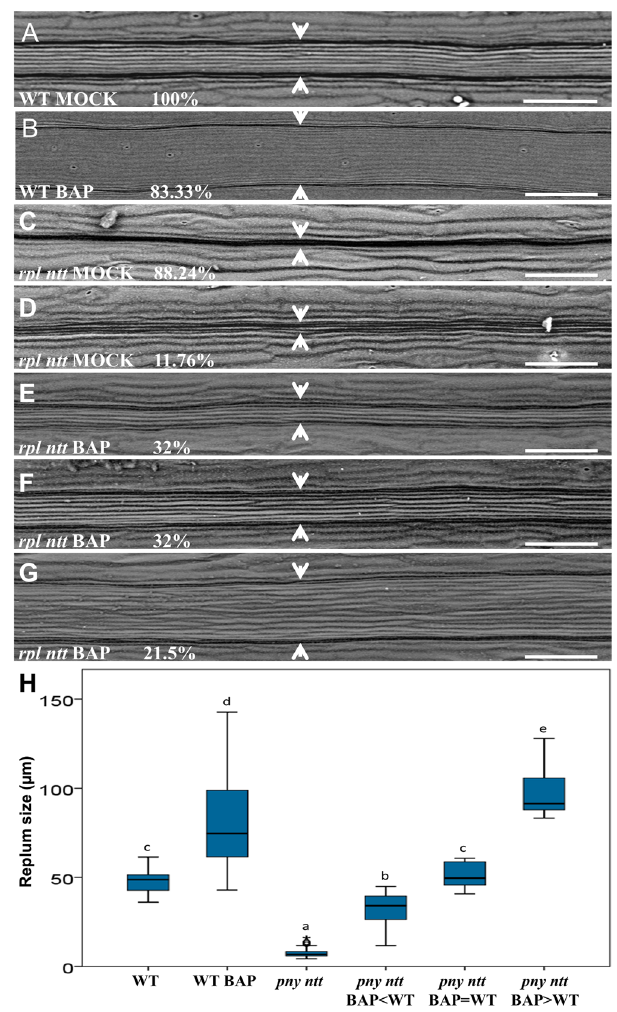
Figure 6. Exogenous cytokinin application increases replum size in Arabidopsis thaliana . ( A ) Mock-treated wild type gynoecium. ( B ) BAP-treated wild type gynoecium that developed a wider replum. ( C , D ) Mock- treated rpl ntt gynoecium that lacks or has a very narrow replum, respectively. ( E – G ) BAP-treated rpl ntt gynoecia where replum development is recovered, at different levels (arbitrary divided in three groups): The replum developed less than observed in WT ( E ); The replum developed as observed in WT ( F ); The replum developed more than observed in WT ( G ). ( H ) Replum size comparison of wild type (WT) and rpl ntt fruits of mock and BAP-treated plants (pny = rpl ). Letters represent a statistical group, an ANOVA multiple range test was performed. Arrowheads indicate replum width. Scale bars: ( A – G ) 100 µ m. ( A , B ) n = 24; ( C , D ) n = 17; ( E – G ) n =